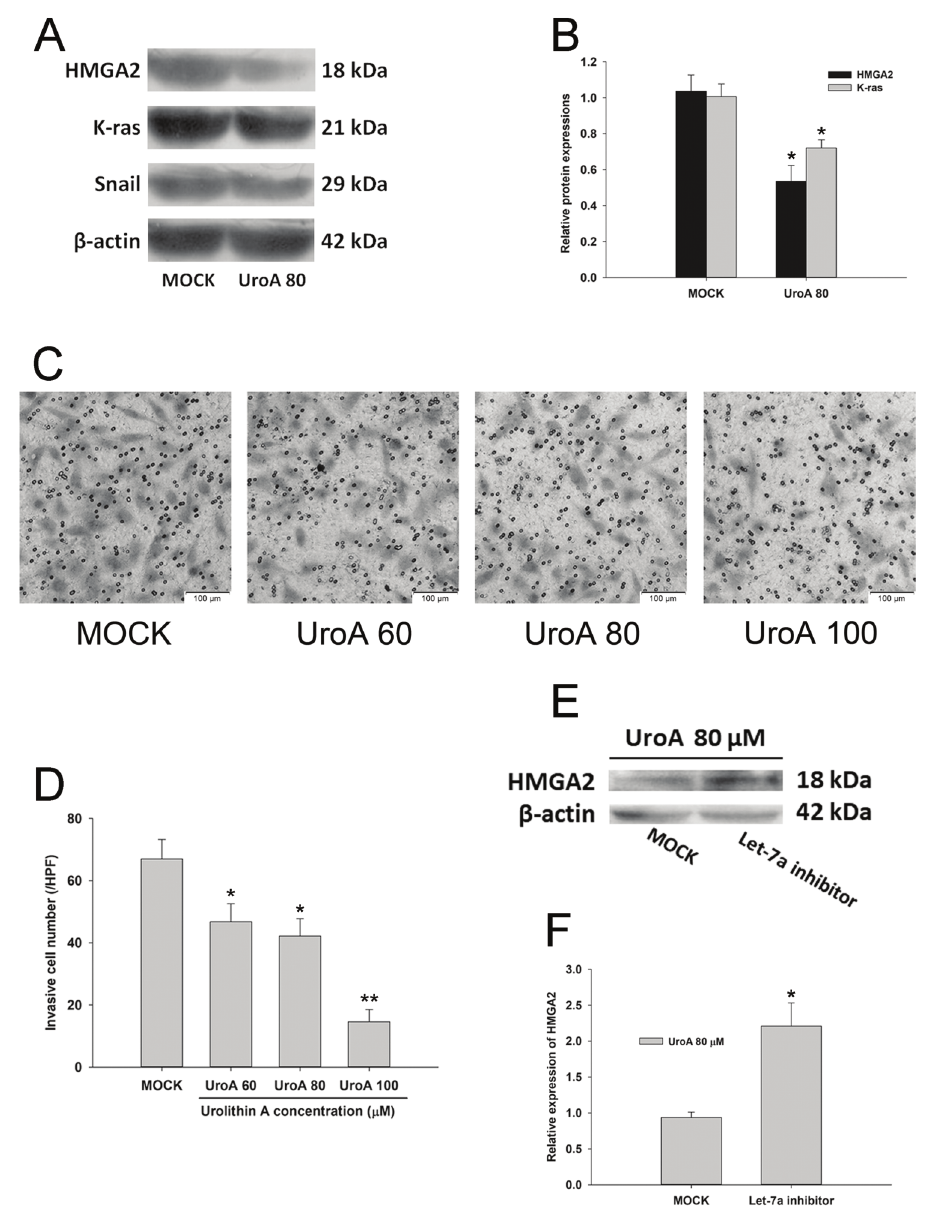
Figure 4. Urolithin A (UroA) suppressed cell invasion by targeting HMGA2/K-ras axis. A , Western blotting analysis of HMGA2, K-ras, and Snail in HepG2.2.15 cells treated by urolithin A (80 m M). B , HMGA2 and K-ras protein levels quanti fi ed by western blot optical analysis. Quantitative data are reported as means ± SD (n=3). C , Cell invasion was evaluated by a Matrigel invasion assay after 48 h incubation with urolithin A (60, 80, and 100 m M). Magni fi cation bar: 100 m m. The average cell number migrated per high power fi elds (HPF) is shown in D . Quantitative data are reported as means ± SD (n=3). E , Let-7a inhibitor abolished the suppressing effects of urolithin A on HMGA2 expression by western blot analysis. F , Quantitative data from 2 blots shown in E . n=3. Data are reported as means ± SD. *P o 0.05, **P o 0.01 compared to the MOCK group